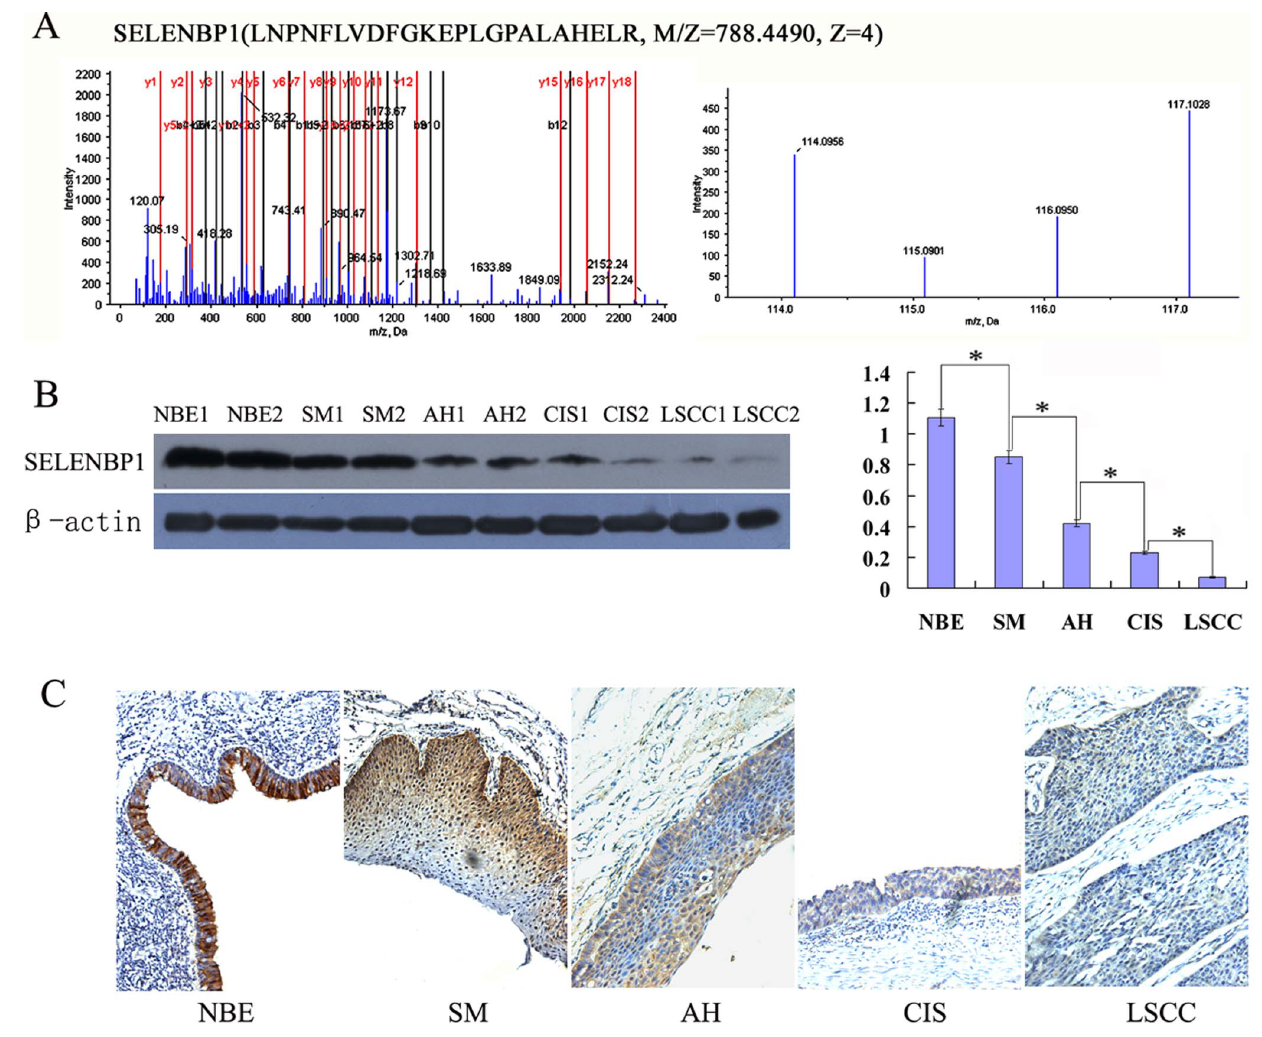
Figure 1. Expressional changes of SELENBP1 in the human bronchial epithelial carcinogenic process. A , MS/MS spectra used for the identification and quantitation of SELENBP1. ( left ) the sequence LNPNFLVDFGKEPLGPALAHELR allows the identification of SELENBP1. ( right ) the released iTRAQ reporter ions provide the relative quantitation of SELENBP1 from the four tissues evaluated. NBE, labeled with iTRAQ reagent 117; SM, labeled with iTRAQ reagents 114, AH/CIS, labeled with iTRAQ reagent 116; and invasive LSCC, labeled with iTRAQ reagent 115. B , detection of SELENBP1 expression in the microdissected tissues by Western blotting. ( left ) a representative result of Western blotting shows the expressions of SELENBP1 in the microdissected NBE, SM, AH, CIS and invasive LSCC; ( rig ht) histogram shows the expression levels of SELENBP1 in these tissues as determined by densitometric analysis. b -actin is used as the internal loading control. Columns, mean from 10 cases of tissues; bars, S.D. (*, P , 0.05 by One-way ANOVA). C , detection of SELENBP1 expression in the formalin-fixed and paraffin-embedded archival tissue specimens by immunohistochemistry. A representative result of immunohistochemistry shows the expression of SELENBP1 in the NBE, SM, AH, CIS and invasive LSCC. Original magnification, 6